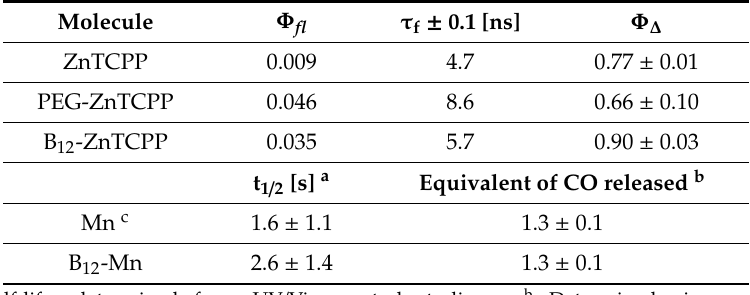
Table 1. Fluorescence quantum yield ( Φ fl ), lifetime ( τ f) and singlet oxygen quantum yield ( Φ ∆ ) of the porphyrin complexes in DMSO. Photo-induced CO-release kinetics of the manganese complexes in PBS bu ff er pH